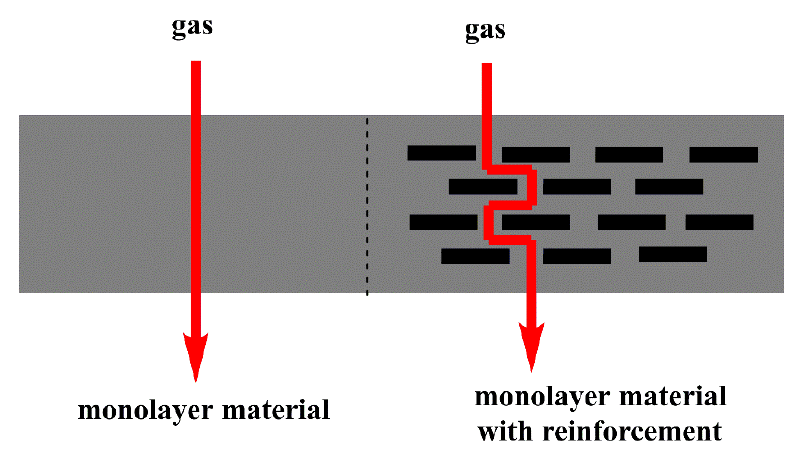
Figure 2. Gas diffusion through a matrix with and without nanoparticles.